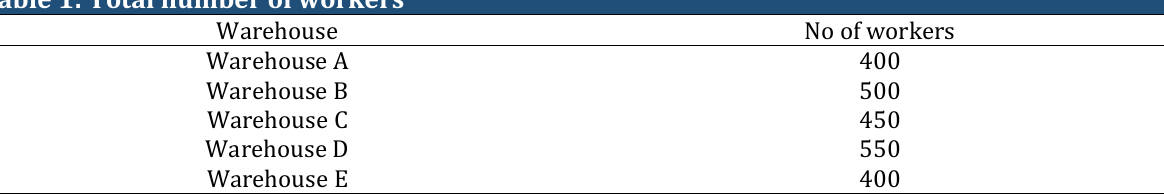
Table 1: Total number of